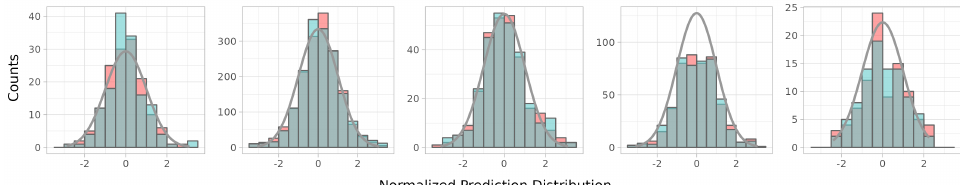
Figure 5. Model performance. Differences are displayed from the mean value of five model